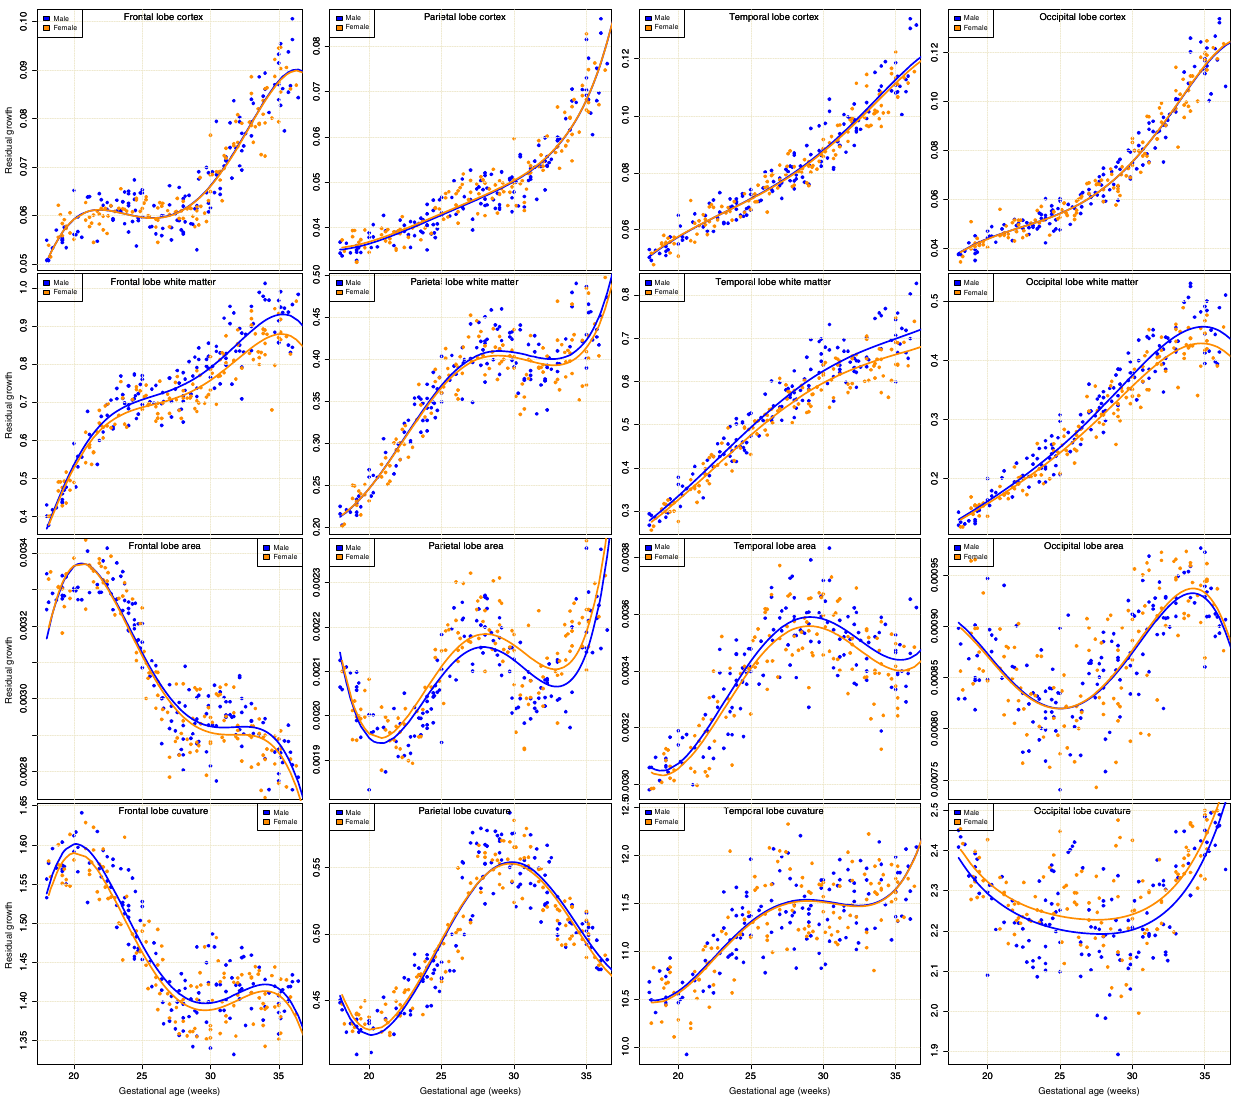
Fig. 3 Residual lobe measure growth trajectories after accounting for global measures. Graphs of residual lobe measures of volume, surface area, and average absolute mean curvature after covarying for intracranial volume, total brain area, and average brain curvature, respectively. Model fi ts are shown for male and female data after transformation back to the measurement domain for visualization. The earlier expansion of the frontal lobe is followed by increases in parietal, temporal, and then occipital lobes over the 18 weeks of growth, each contributing to the global measure and resulting in a complex residual growth trajectory. The cortical tissue volume (top row) is seen to follow almost identical trajectories in male and female fetuses in all lobes, occupying the same proportion of ICV at all ages, while residual growth of white matter volume, surface area, and curvature diverge in different